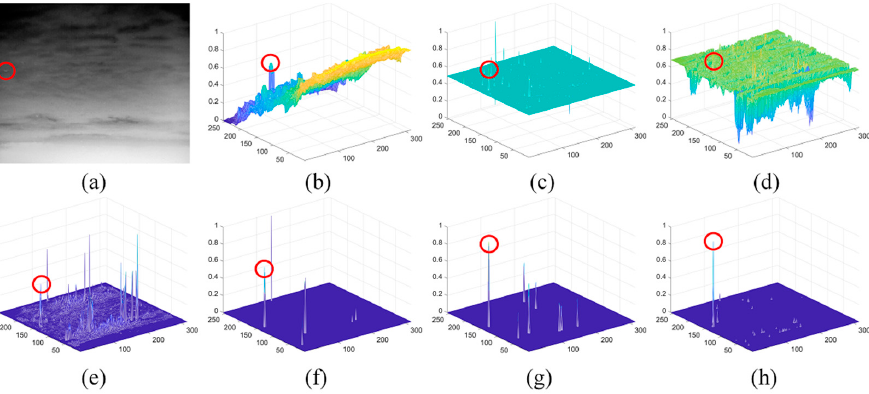
Figure 11. The detection results of different methods on S2: ( a ) the 17th image in S2 and ( b ~ h ) nor- malized 3-D mesh obtained by the LCM [18], IPI [10], MCPM [19], LIG [22], PSTNN [12], FKRW [15], and the proposed method, respectively.